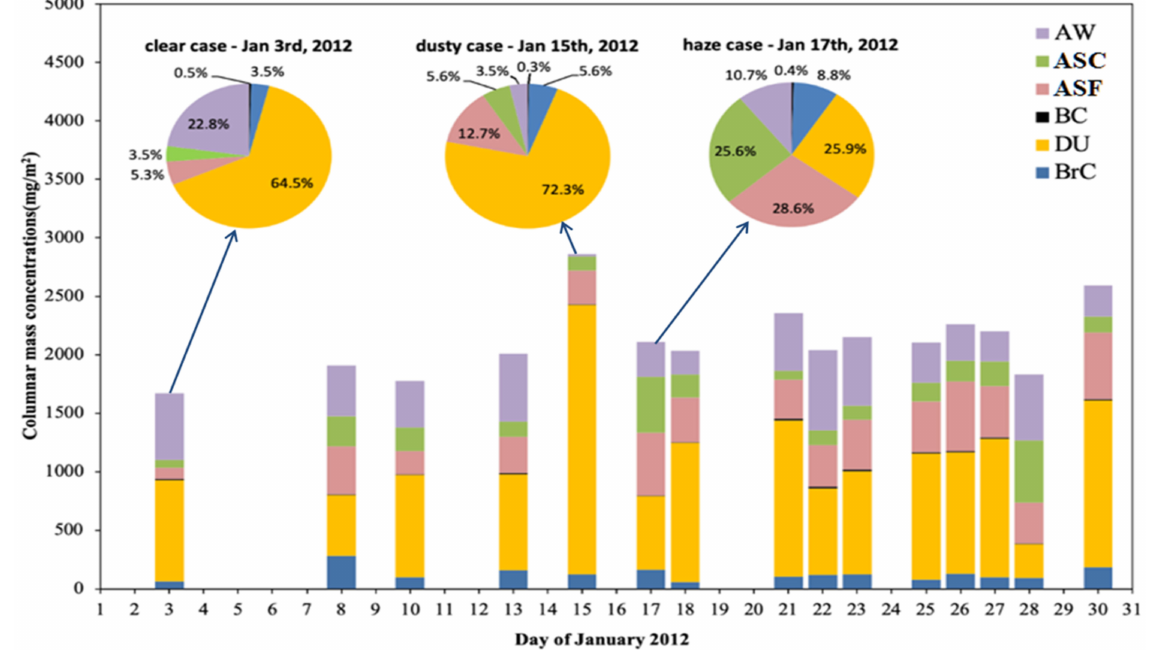
Figure 12. Time series of the daily mean of observed aerosol component mixtures, including BC, BrC, DU, ASF, SS, AW in Beijing region. The pie charts present the average aerosol component mixings for three episodes (clear, dusty and hazy) as marked in the